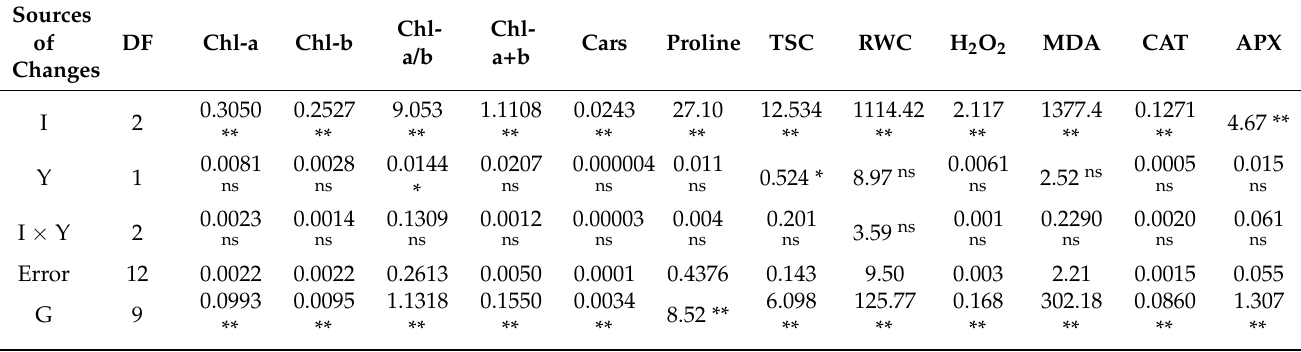
Table 1. Analyses of variance for different traits of ten black cumin genotypes (G) at three irrigation regimes (I) in two years